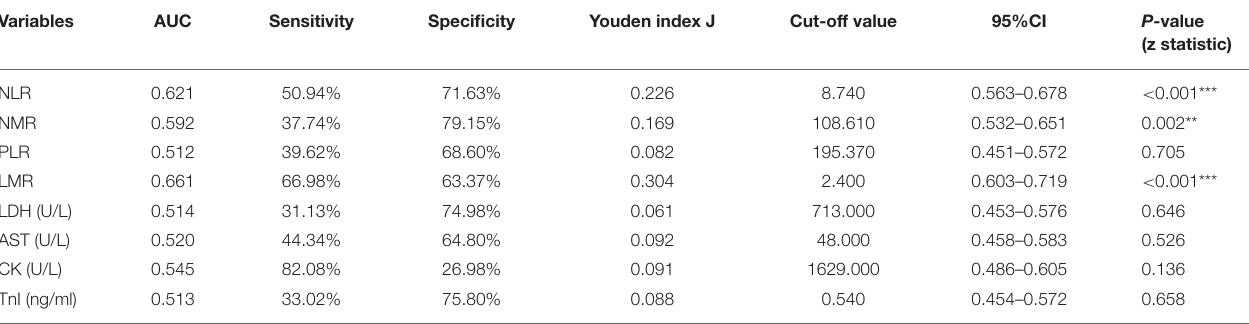
TABLE 4 | The ROC curve and cut-off values of common ratios and markers of myocardial injury predicting in-hospital death in STEMI group. Variables AUC Sensitivity Specificity Youden index J Cut-off value 95%CI P -value